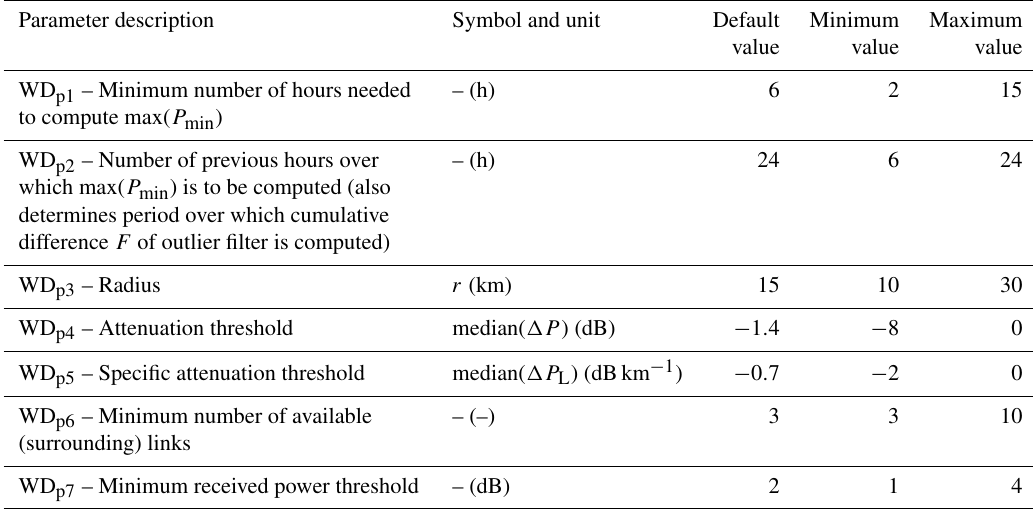
Table 1. Wet–dry classification parameters (WD p n ): default values from RAINLINK and calibration search space (minimum and maximum values). Modified from Overeem et al. (2016a).